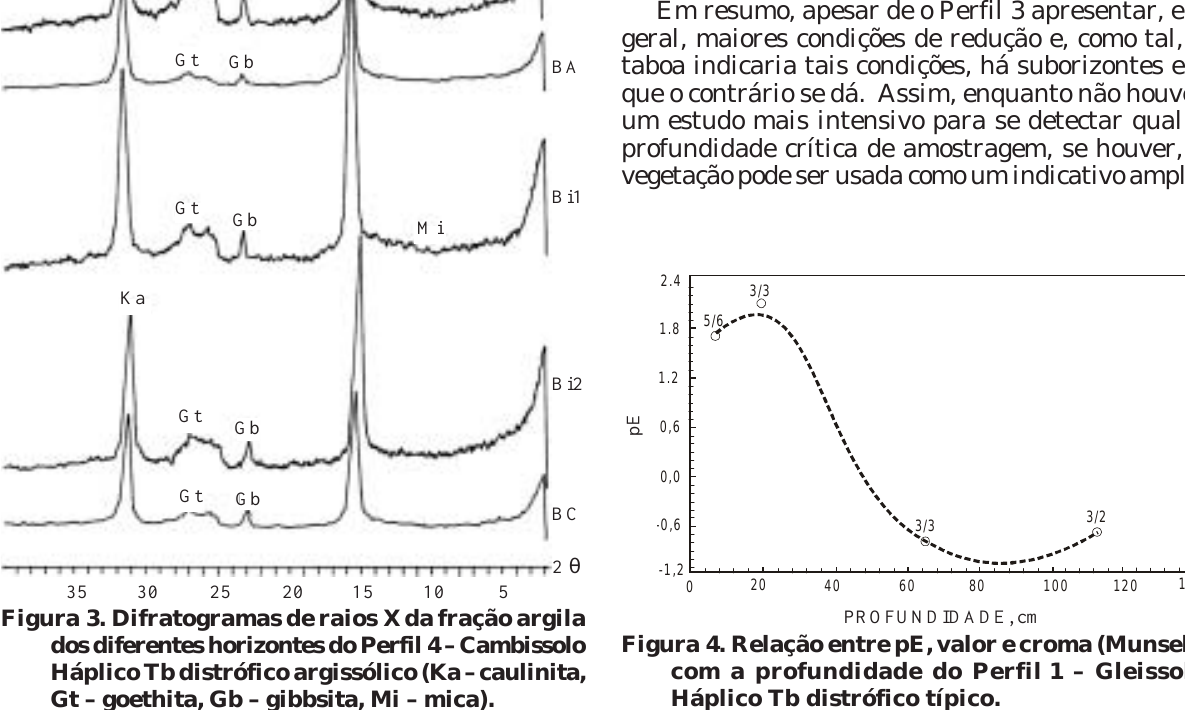
Figura 3. Difratogramas de raios X da fração argila dos diferentes horizontes do Perfil 4 – Cambissolo Háplico Tb distrófico argissólico (Ka – caulinita, Gt – goethita, Gb – gibbsita, Mi – mica).